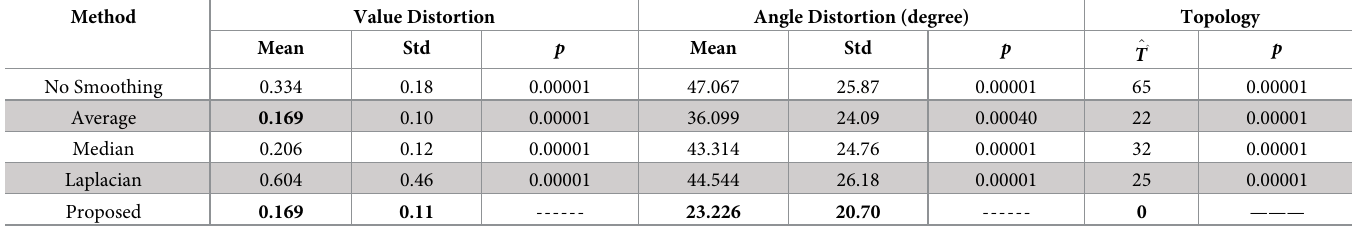
Table 3. Comparison of different smoothing methods based on three metrics: value deviation, angle distortion, and number of flipped triangles with a large amount of noise (PSNR = 5). Method Value Distortion No Smoothing